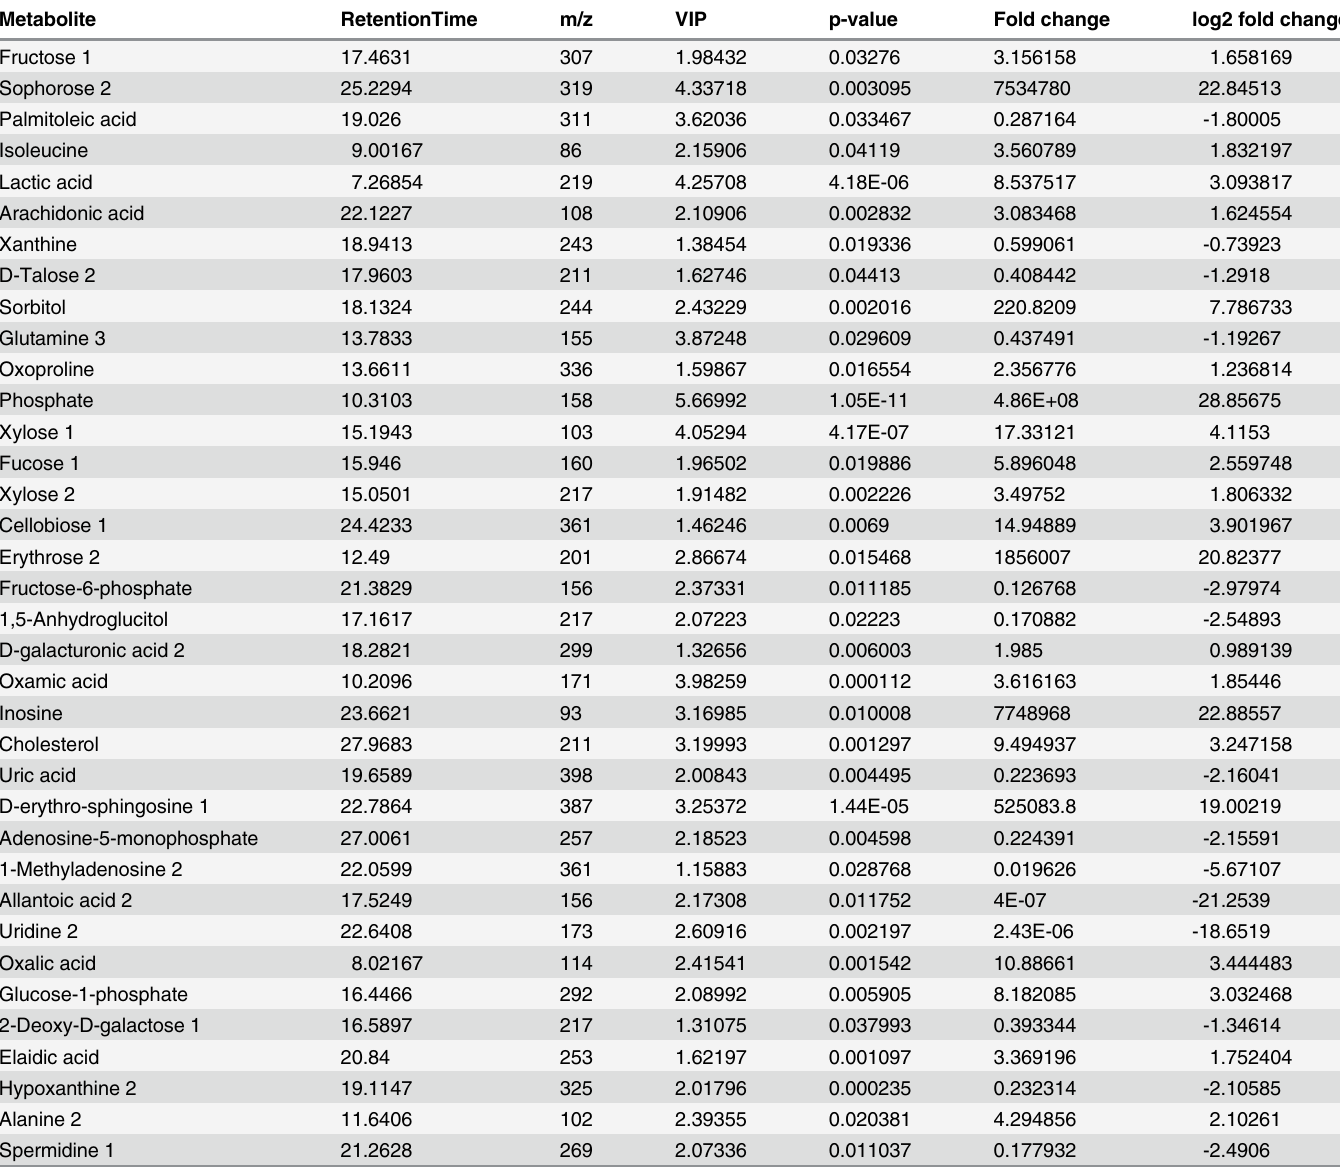
Table 1. Identification results of potential biomarkers detected by GC/MS in liver of D-galactose group. Metabolites which VIP > 1 and p-value < 0.05 have been showed in Table 1. If the value of log2 FOLD CHANGE is positive, the contect of that metabolite in D-galactose is greater than control group, If the value of log2 FOLD CHANGE is negative, the contect of that metabolite in D-galactose is less than control